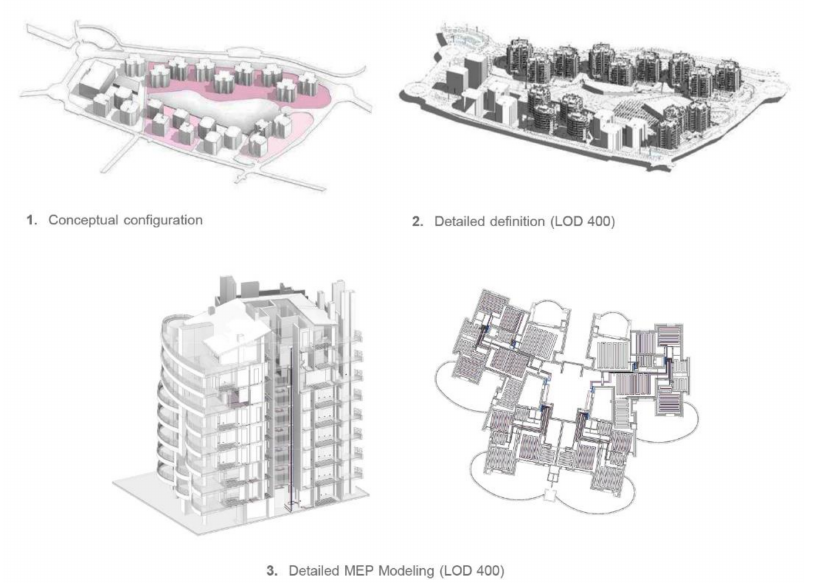
Figure 6. The evolution phases of the BIM model LOD, according to the objective definitions and energy